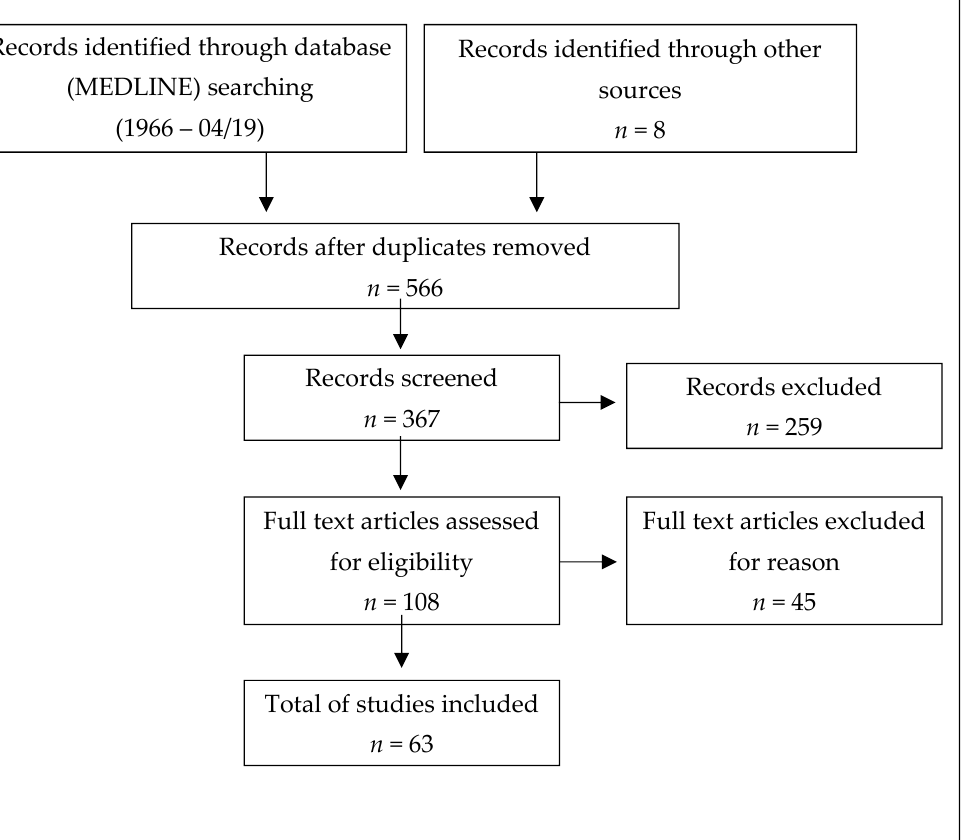
Figure 1. PRISMA flow diagram of the reviewed literature.